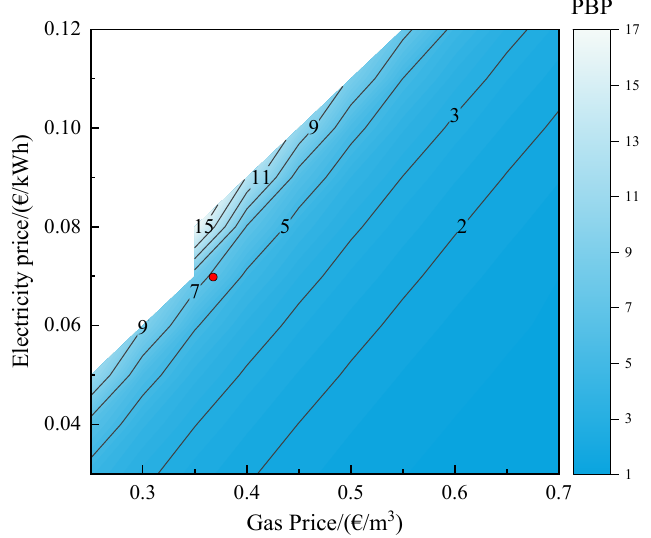
Figure 11. PBP with various electricity and gas prices. In China, the gas price and electricity price are different in different provinces. The PBP of the HTCHP system applied in different provinces is shown in Table 4. The energy price ratio is defined as the ratio between the electricity price and gas price, which provides obtained that the use of the HTCHP system in Yunan, Guangdong, Guizhou, and Liaoning achieves PBP in the range from 3.3 to 4.6 years, due to the high gas price in these provinces with an energy price ratio lower than 1.81. The use of this technology seems not to be attractive in Hubei, Qinghai, and Neimenggu because of their very low gas price. Table 4. PBP for HTCHP industrial application in different provinces in